Question: Summarize what this figure shows in one sentence.
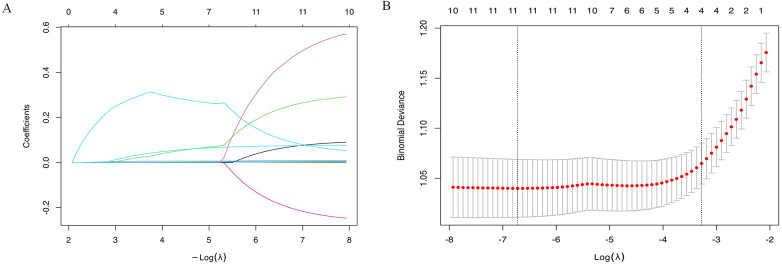
Answer: Variable selection using LASSO regression from candidate routine blood parameters. (A) Coefficient profile plot showing the shrinkage of candidate variable coefficients as the penalty parameter λ increases; (B) Cross-validation binomial deviance curve; the optimal λ was selected using the one-standard-error criterion (indicated by the right vertical dashed line), resulting in the retention of four key predictors: WBC, NEU, PLT, and AL. WBC, white blood cell count; NEU, neutrophil count; PLT, platelet count; AL, atypical lymphocyte proportion.